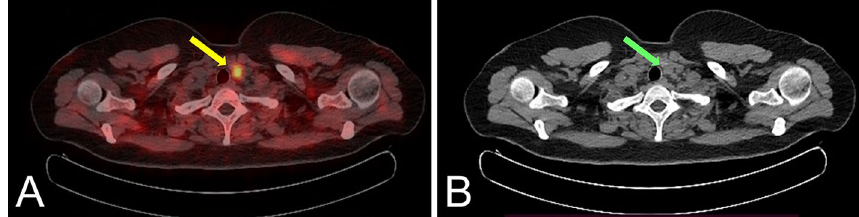
Fig. 3 Axial [ 18 F]fluorocholine PET/CT images ( A ) showing hyperfunctioning parathyroid in the middle-lower third of the left thyroid lobe (SUVmax 6.0 in the late phase) (yellow arrow) and CT coregistration ( B )